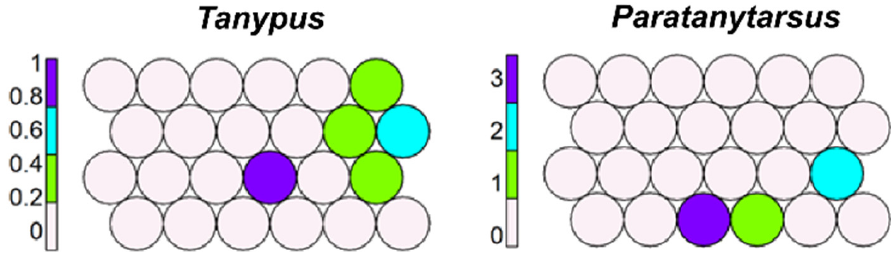
Figure 9. Unsupervised map of other two ubiquitous morphotaxa.